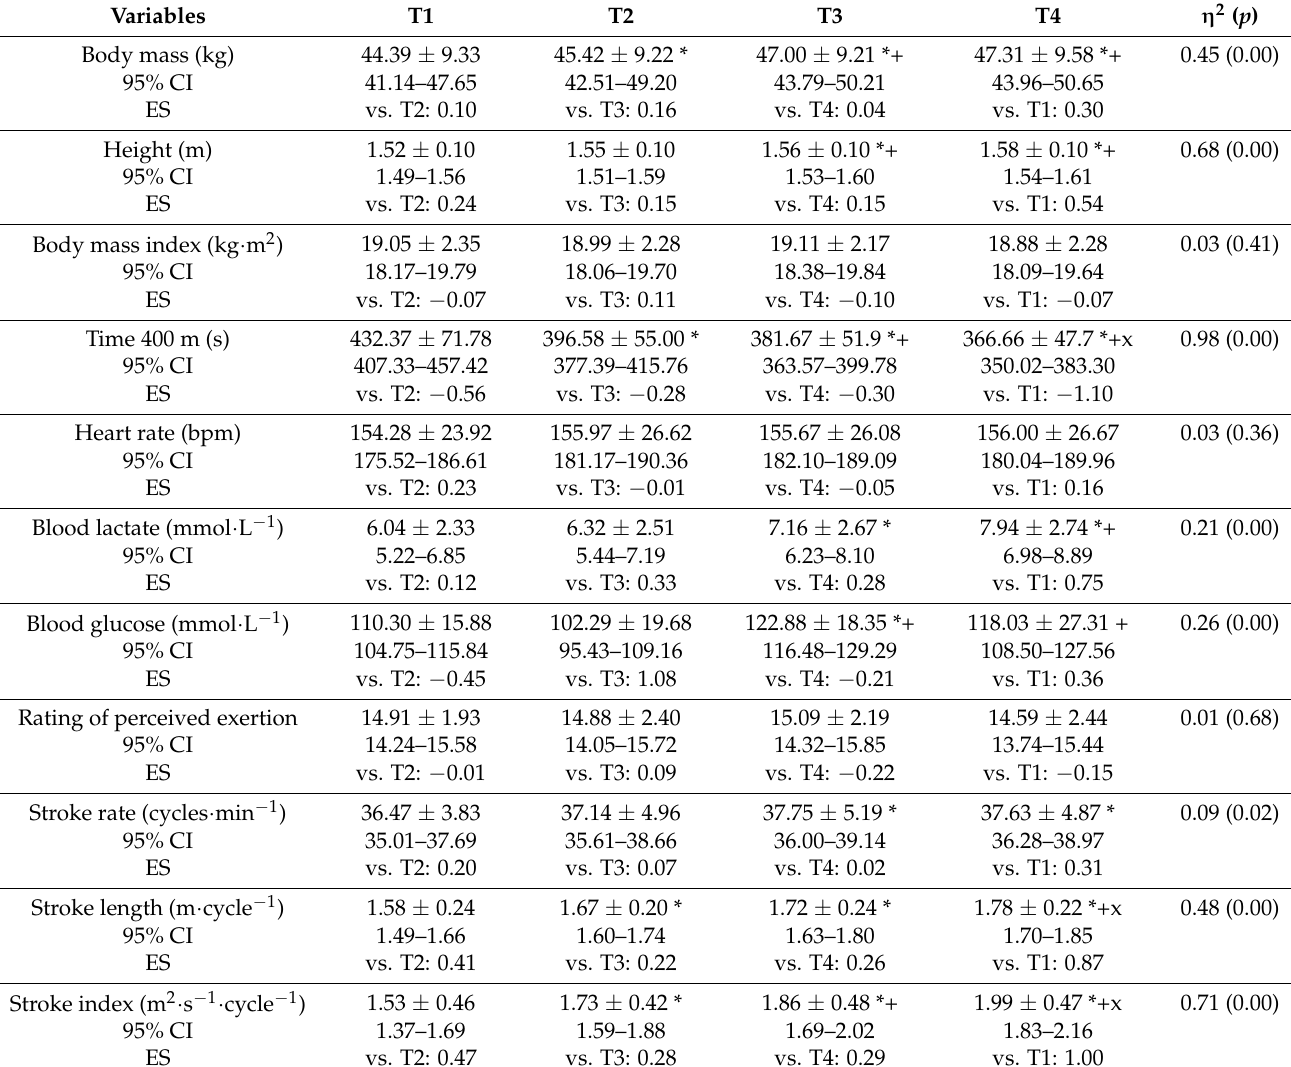
Table 3. Changes in swimmers’ anthropometric, physiological, and biomechanical variables during the four 400 m front crawl testing moments. Mean ± SD, 95% confidence intervals (95% CI), and effect size (ES) are